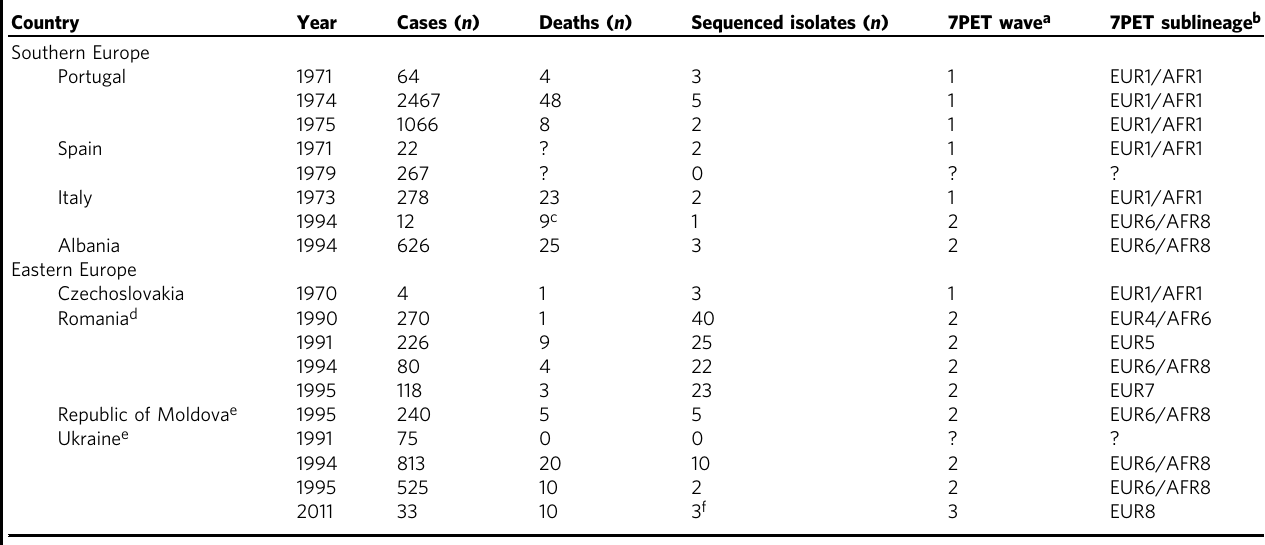
Table 1 Main cholera outbreaks reported by European countries, except for the Russian Federation, according to the World Health Organization (WHO).